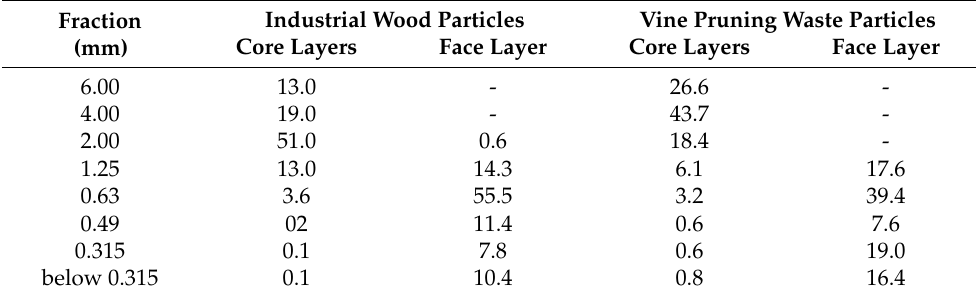
Table 1. Fractional composition of used raw